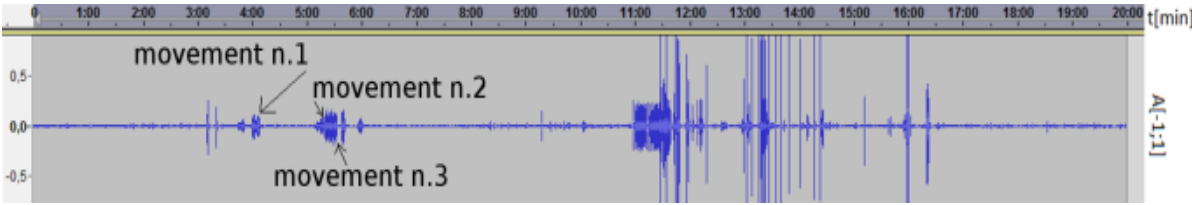
Figure 10. Recorded sound data of subject No. 2.